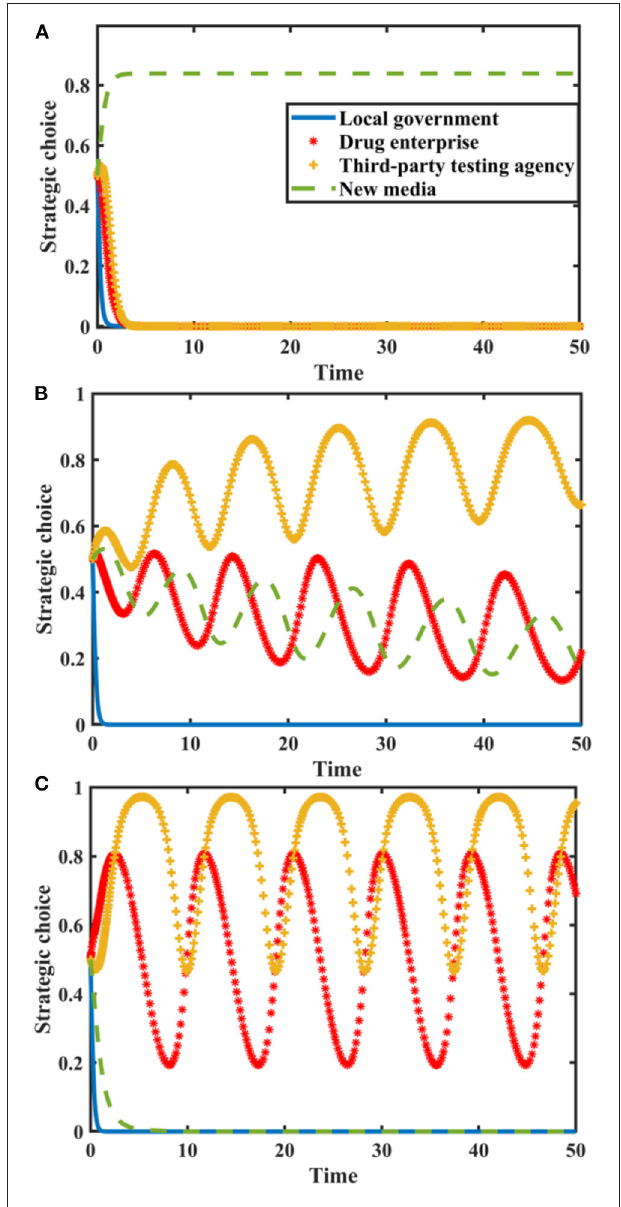
FIGURE 7 | Impact of δ and on the evolution of each player’s strategy. Figure is the simulation diagram that shows the influence of the influence effect of new media reports and additional revenue from distorted reporting on the strategic choices of local government, drug enterprises, third-party testing agencies, and new media. (A) When the situation δ = 0.0, R mh − R ml = 0.0, (B) When the situation δ = 0.4, R mh − R ml = 2.0. (C) When the situation δ = 0.8, R mh − R ml =